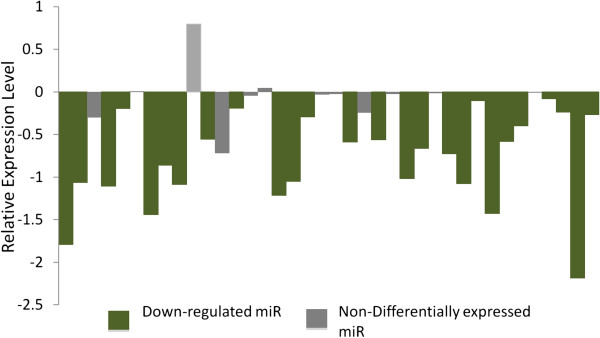
Downregulation of C14 miRNA cluster in GBM. On the Y-axis the difference of the median normalized expression levels between GBM and controls (Median_GBM – Median_Control) are plotted for each miRNA (X-axis). Negative values indicate lower expression in GBM. The miRNAs from left to right are, MiR-379, 411, 299-3p, 299-5p, 380-3p, 380-5p, 323, 758, 329, 494, 495, 376a, 376a*, 654, 376b, 381, 487b, 539, 544, 655, 487a, 382, 134, 668, 485-3p, 485-5p, 453 (323b), 154, 154*, 496, 377, 409-3p, 409-5p, 412, 369-3p, 369-5p, 410 and 656. Green bars indicate significant downregulation in GBM after genome-wide Bonferroni correction (miR names are in bold above). Grey bars indicate expression changes that are not significant post correction. The normalized data were obtained from the TCGA server. Mann-Whitney U test was applied to analyze differential expression. A p value less than 0.05 (post correction) is considered significant. As seen in the figure for the entire cluster (on the horizontal axis) the miRNAs were significantly downregulated in GBM pointing to a coordinated situation.